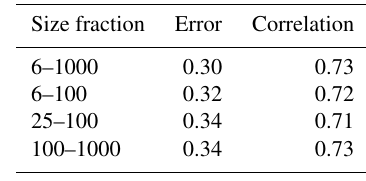
Table 4. Goodness-of-fit estimates for GLMM as expressed by the mean absolute error relative to the dependent variable mean and by Spearman’s rank correlation coefficient separately in the size frac- tions of 6–1000, 6–100, 25–100 and